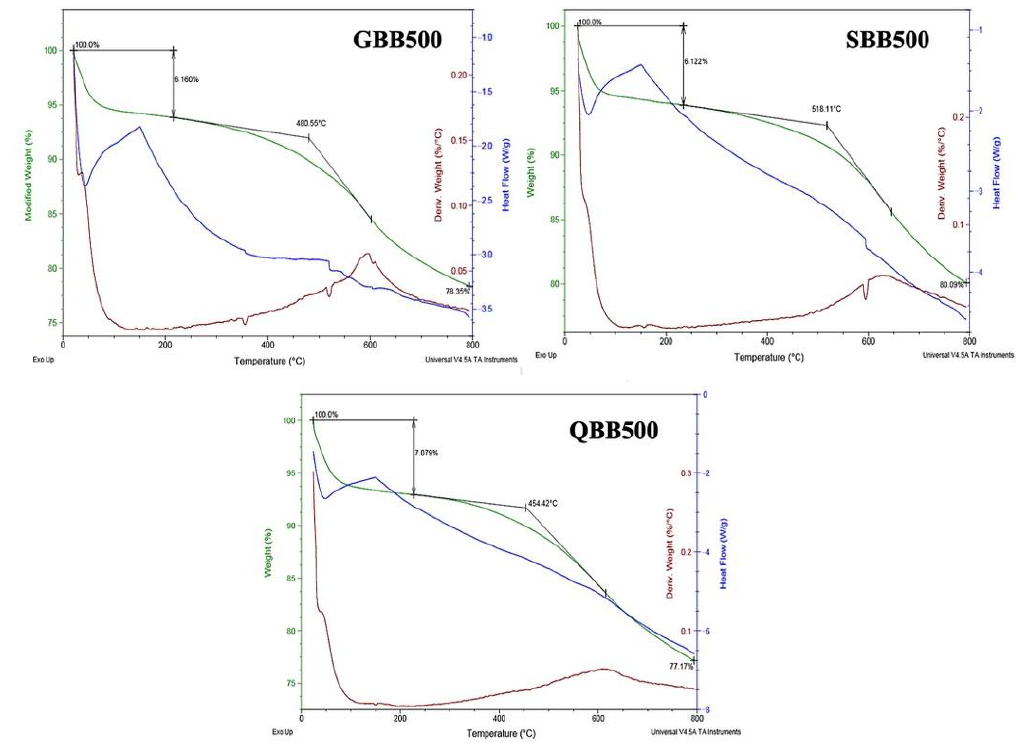
Figure 6. Thermogravimetric analysis of three types of biochar prepared at preparation temperature T = 500 °C. T = 500 ◦